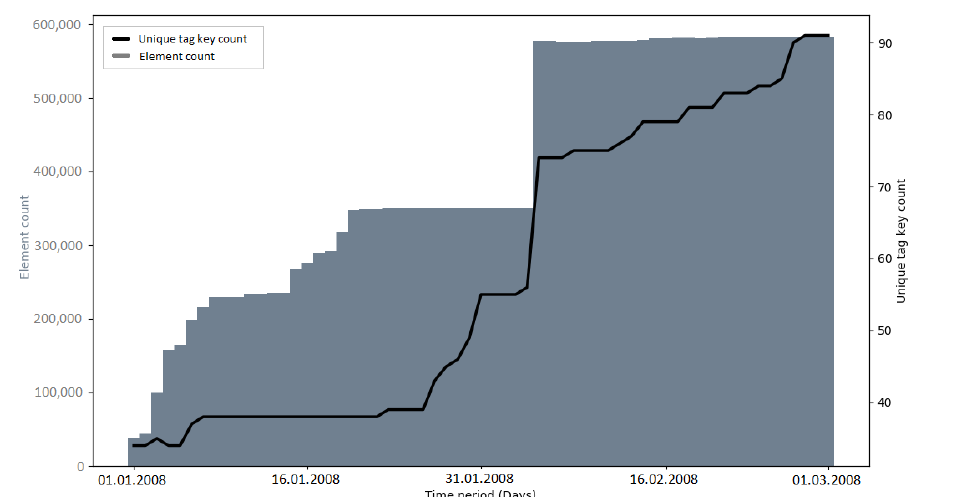
Figure A21. Number of tag keys during the AND import.